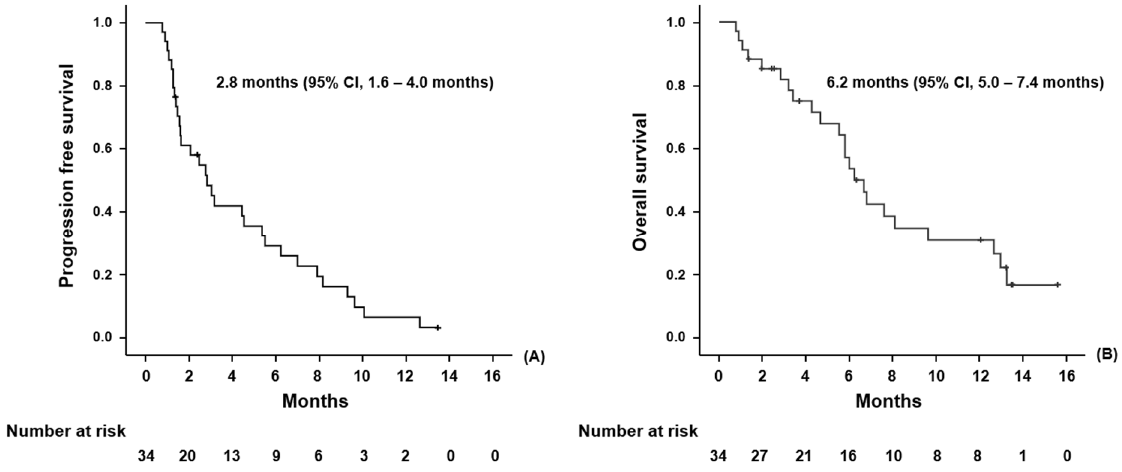
Figure 1. Kaplan–Meier curves for progression-free survival ( A ) and overall survival ( B ).